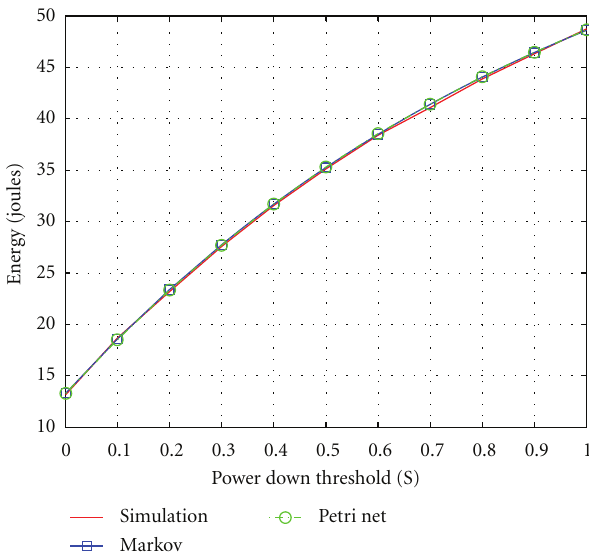
Figure 6: P ow e r Up De lay = 0 . 3 seconds.